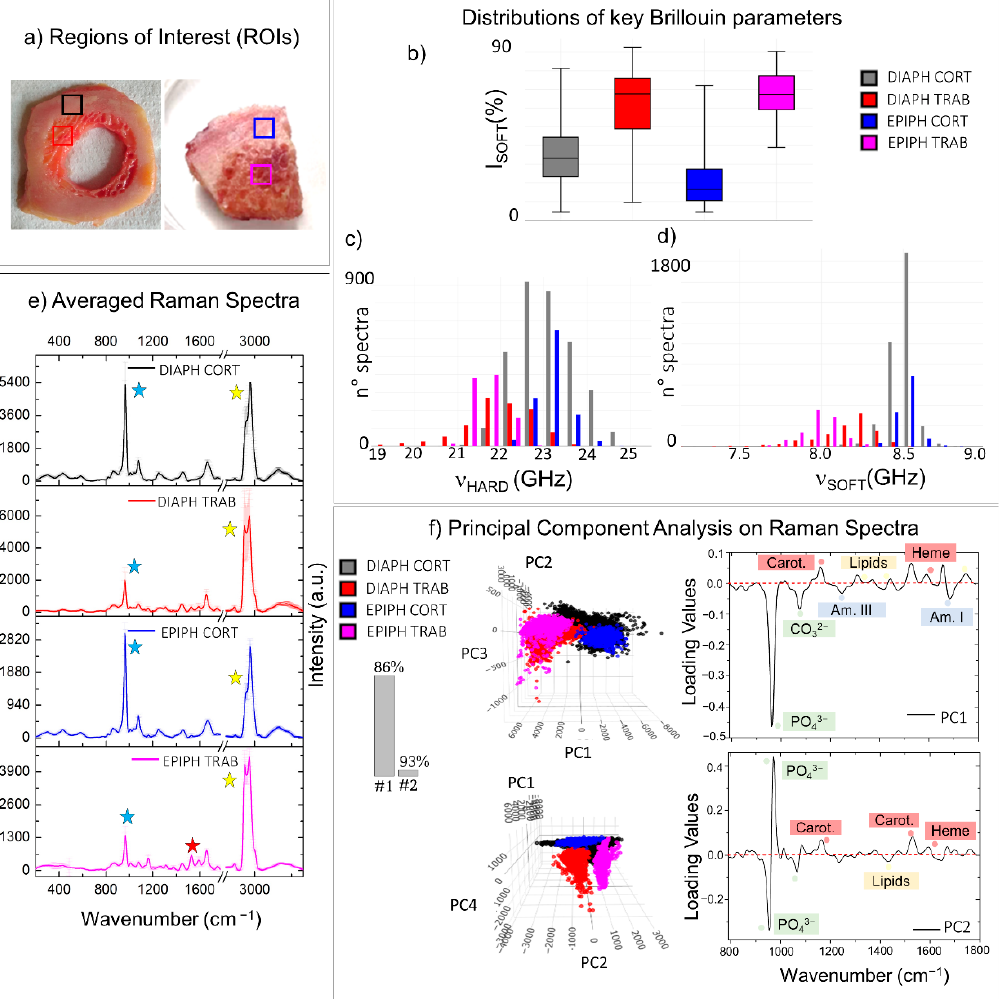
Figure 5. Comparison between regions of interest (ROIs) collected from cortical and trabecular bone tissue types belonging to different anatomical portions. ( a ) Pictures of two different tissue sections both excised from the human femur and then frozen at -80° C: a cross-section of the diaphysis and a section from the infero-medial epiphysis (on the right). The coloured squares enclose ROIs selected for comparisons (black: diaphyseal cortical bone; red: diaphyseal trabecular bone; blue: epiphyseal cortical bone; magenta: epiphyseal trabecular bone). Box plots and histograms report the statistical distributions of relevant Brillouin parameters obtained from the ROIs, namely ( b ) the relative percentage of the P SOFT component, ( c ) the frequency shift ν HARD of the P HARD component, and ( d ) its frequency shift ν SOFT . ( e ) Average of all the normalized Raman spectra obtained from the ROIs. The y-error bars represent the standard deviation of Raman intensities calculated for each of the four datasets. ( f ) Score plots and loading plots of the PCA performed on the Raman spectra of ROIs. Coloured labels in the loading plots are used to stress the presence of spectral features referable to a certain class of macromolecules. The histogram reports the cumulative variance expressed by the first (1#) and the second (#2) principal